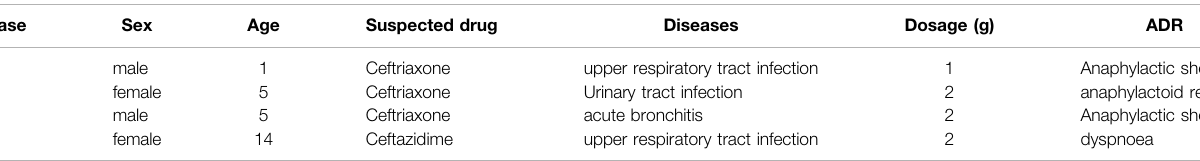
TABLE 7 | Detailed information of the 4 deaths.